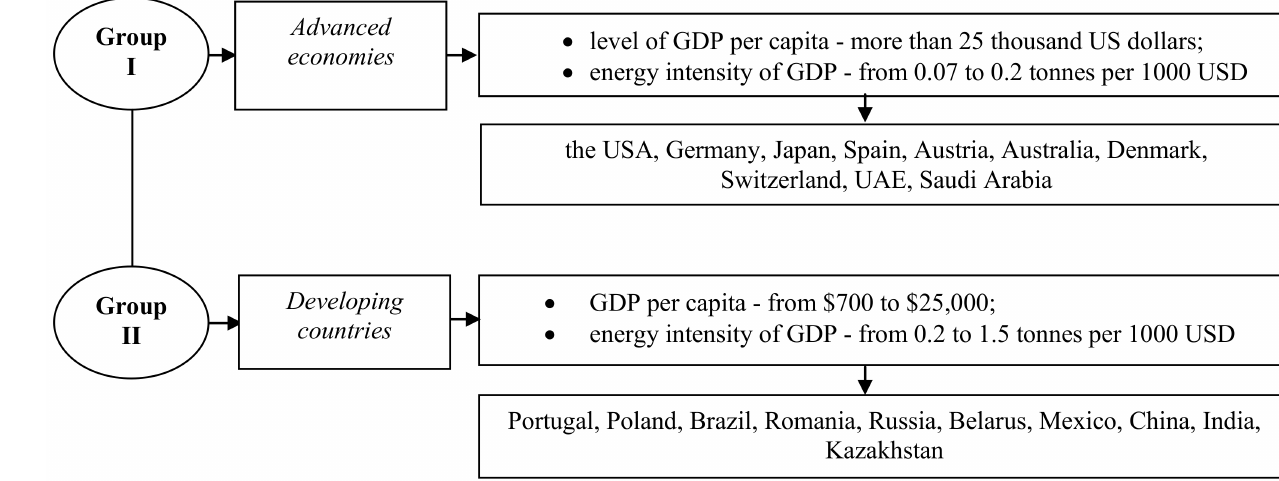
Figure 1. Distribution of the studied countries by groups. Source: generated by the